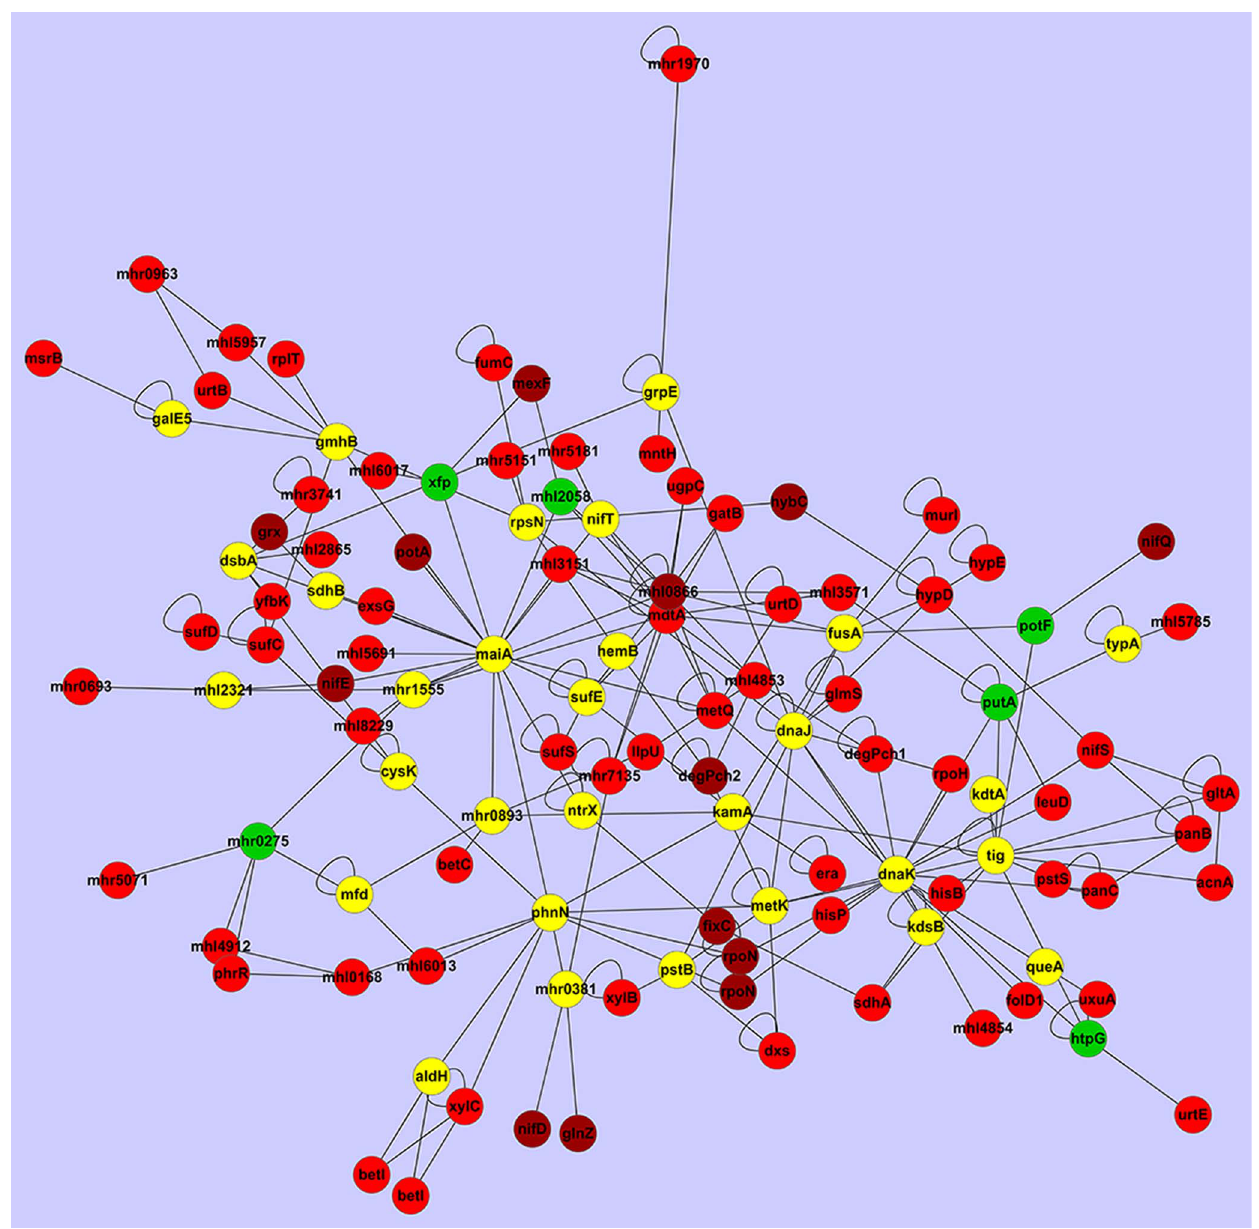
Figure 6. An inter-connected, differentially-expressed PPI subnetwork in bacteroids altered for nitrogen fixation. The genes with differential expression fold change greater than 5 were shown in red; those greater than 20 were shown in dark red; those down-regulated were shown in green and others were shown in yellow.